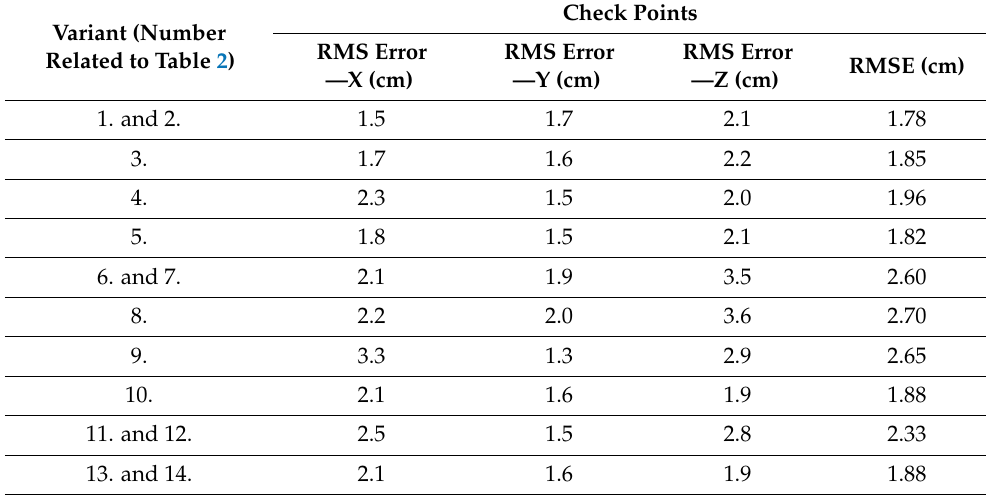
Table 3. Summary of accuracy on check points for variants developed in Pix4D software.